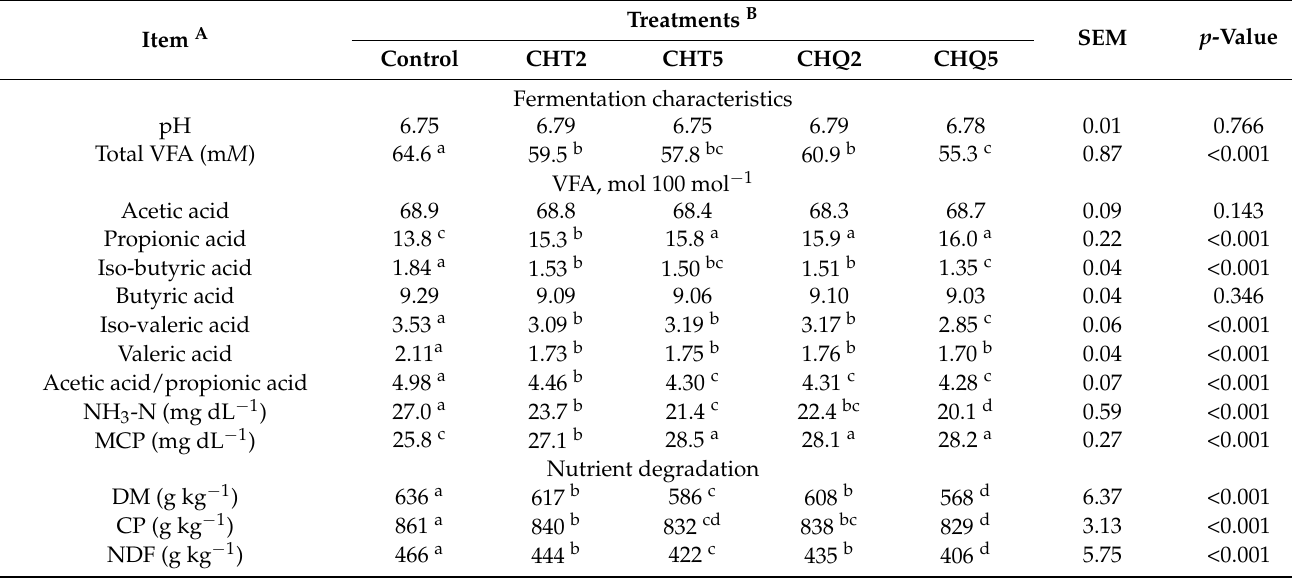
Table 3. Ruminal fermentation characteristics and nutrient degradation in the in vitro fermentation cultures receiving untreated and tannin-treated alfalfa